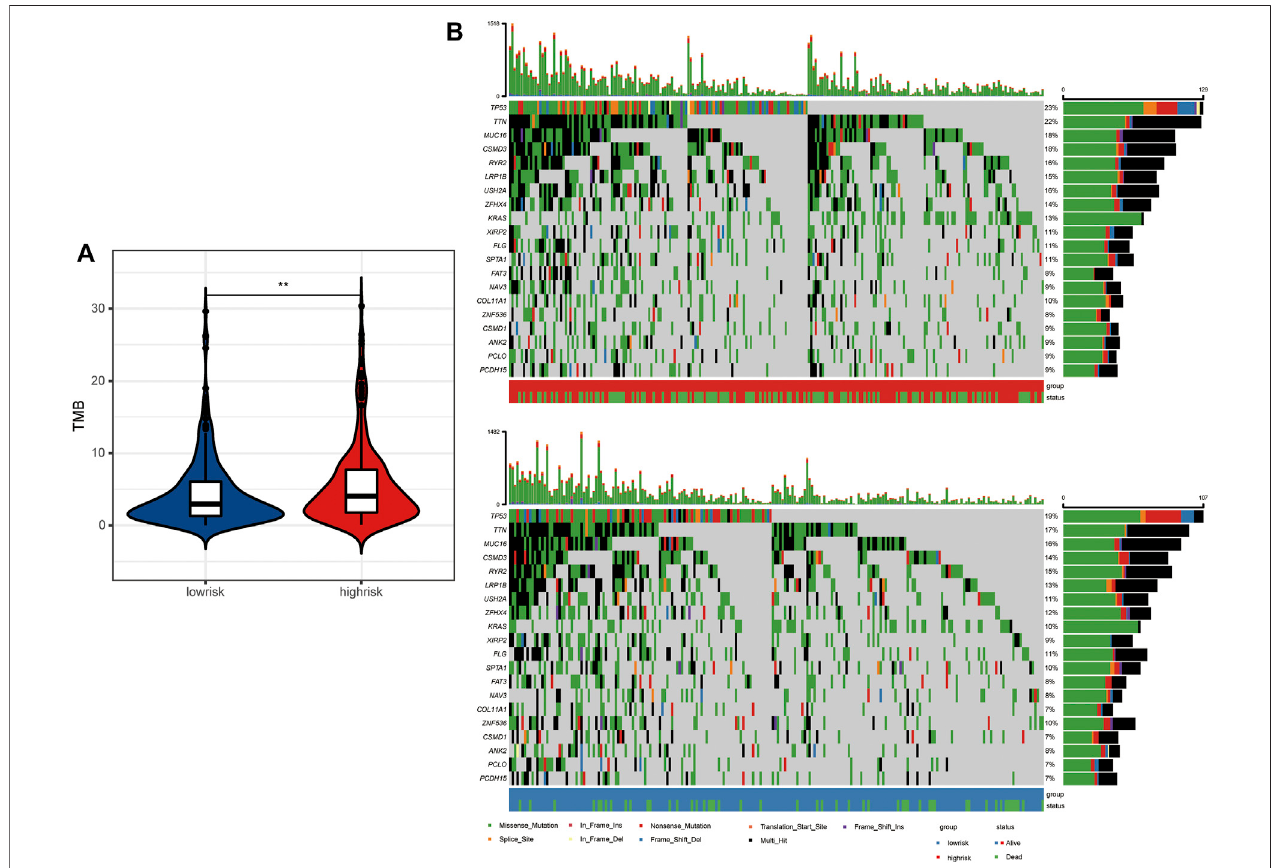
FIGURE 6 | Tumor mutation landscape between high- and low-risk LUAD patients. (A) Tumor mutation burden between high- and low-risk groups. (B) Tumor mutation landscape of high- and low-risk groups.